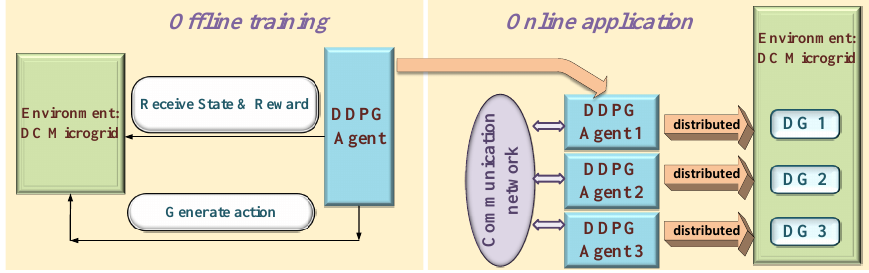
Figure 3. The schematic diagram of the proposed multi-agent DRL-based regulation scheme. The DRL concept is to find the best policy together with the states and actions while getting maximum rewards through the interaction between the agent and the